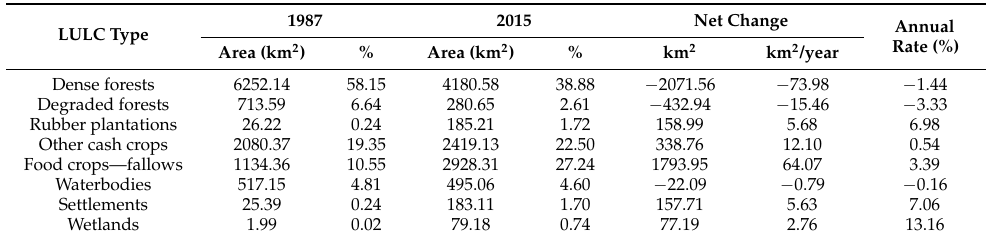
Table 3. LULC change trends in the Upper Espace Taï Region over the period 1987–2015 in south- western C ô te d’Ivoire.